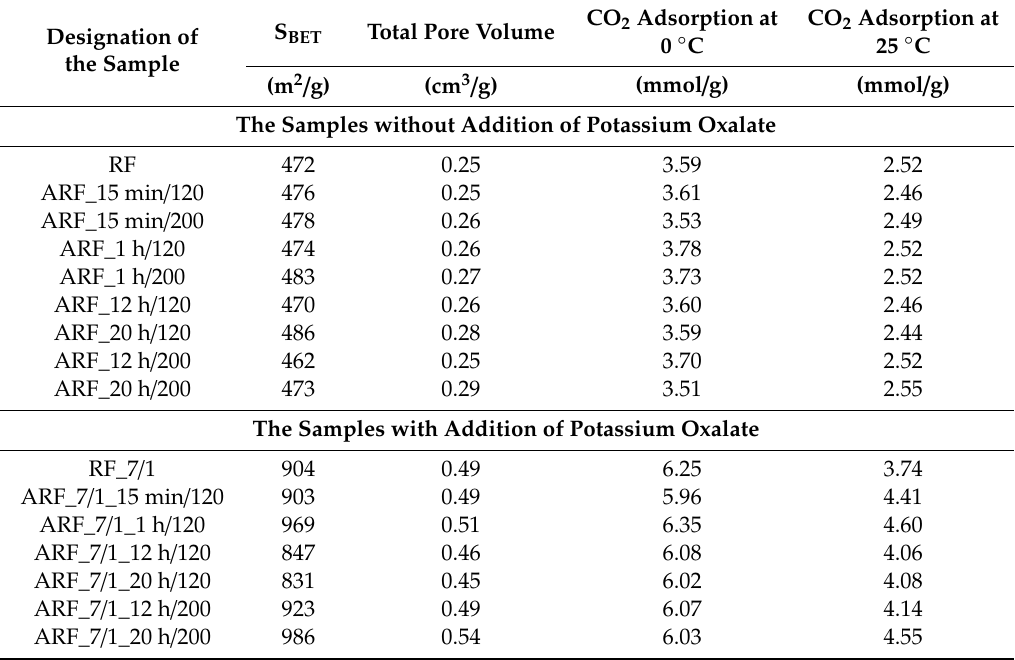
Table 1. Physicochemical properties of the tested samples.